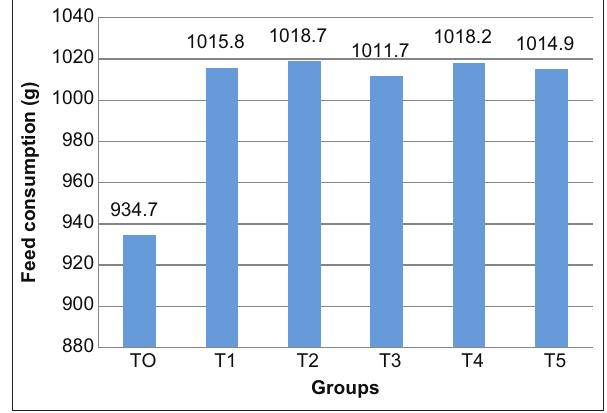
Figure-2: Efficacy of dietary supplementary probiotics on feed consumption of male layer chicken during the starter period. Values are expressed in mean±standard error. One-way analysis of variance was carried out, followed by Duncan’s comparison test. a,b,c Different superscripts indicate significant differences (p<0.05).